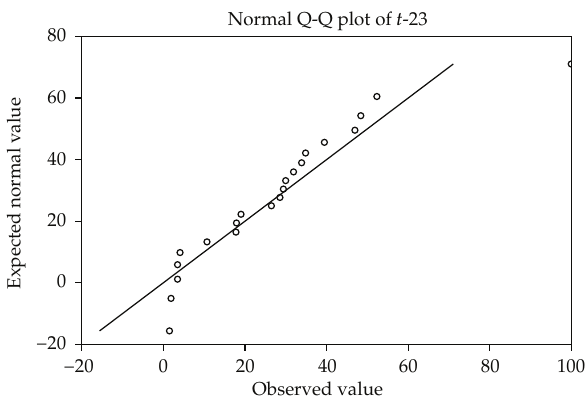
Figure 2: Q-Q of potential di ff erences detected at time t (cid:8) 23s during a seizure. The data collected at this time frame conforms to that of a power law distribution.